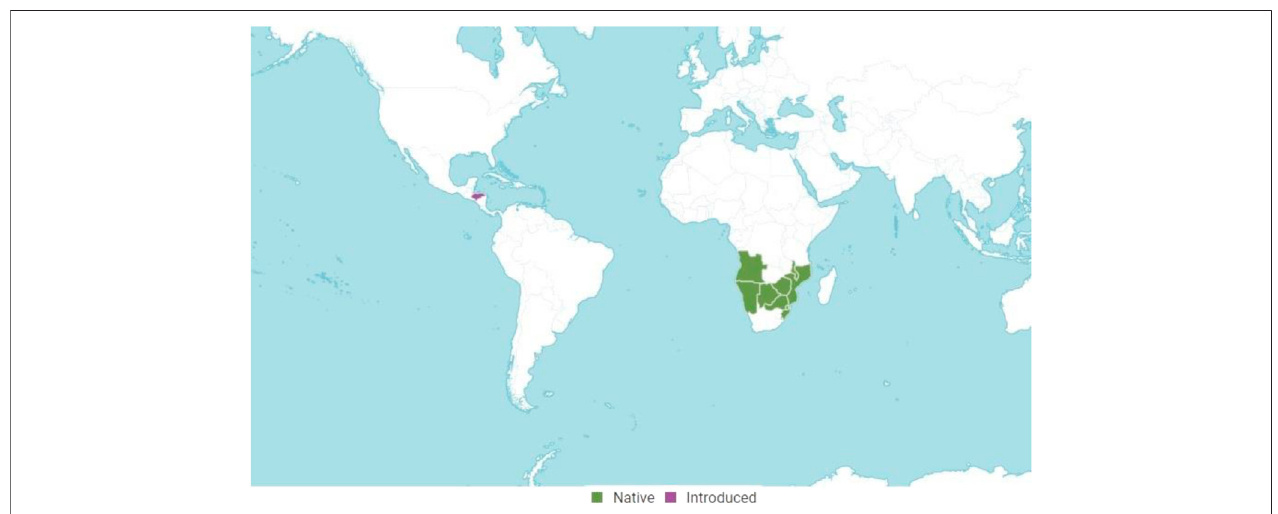
FIGURE 2 | Geographical distribution of T. riparia (Source: Plants of the World Online, Royal Botanic Gardens, Kew. 2022. Licensed under Creative Commons Attribution CC BY).